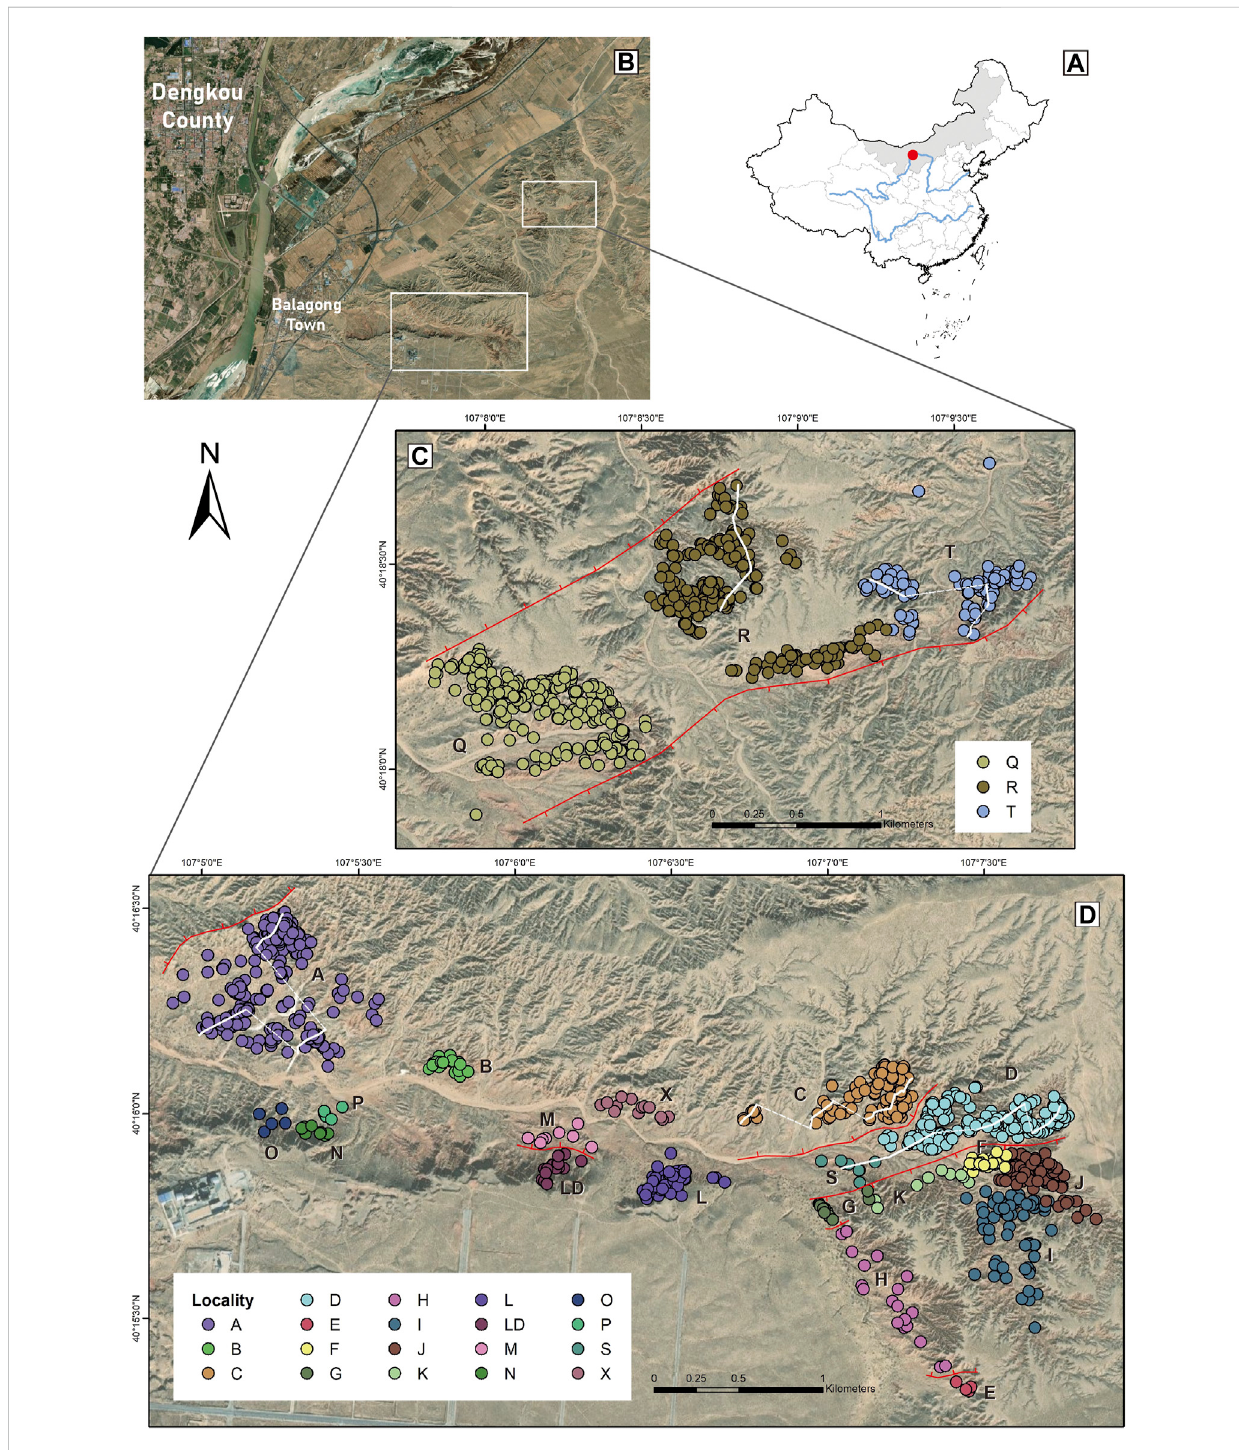
FIGURE 1 Location of Saint Jacques and its fossil localities. (A) Map of China, showing the location of Saint Jacques (red circle) in Nei Mongol (gray area). (B) TheSaintJacquesfossiliferousareaisnearthetownofBalagong,acrosstheYellowRiverfromDengkouCounty.Fossillocalitiesaredenselydistributedin (C) Sanshenggongbei and (D) Langhaogou. White lines in (C) and (D) : measured stratigraphic sections. Red lines: